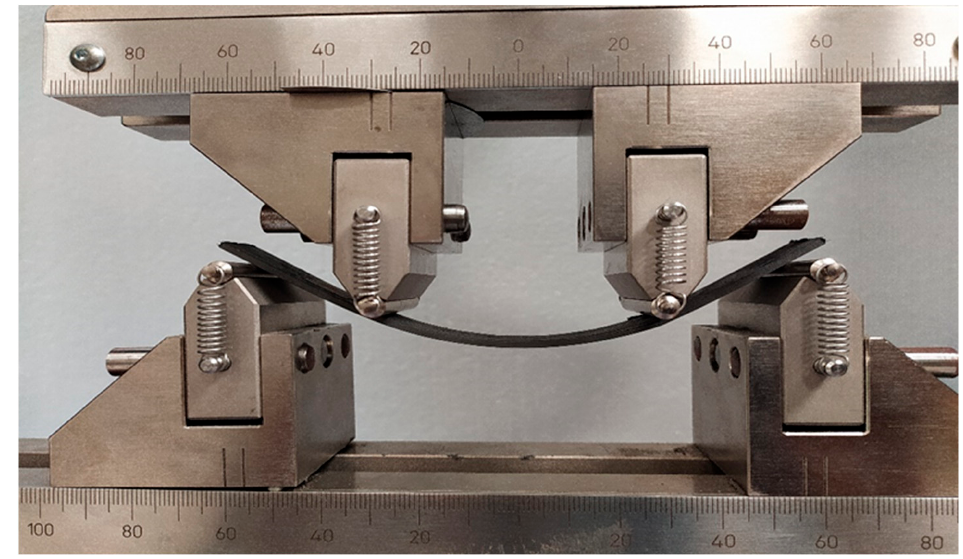
Figure 16. Bending specimen under test.